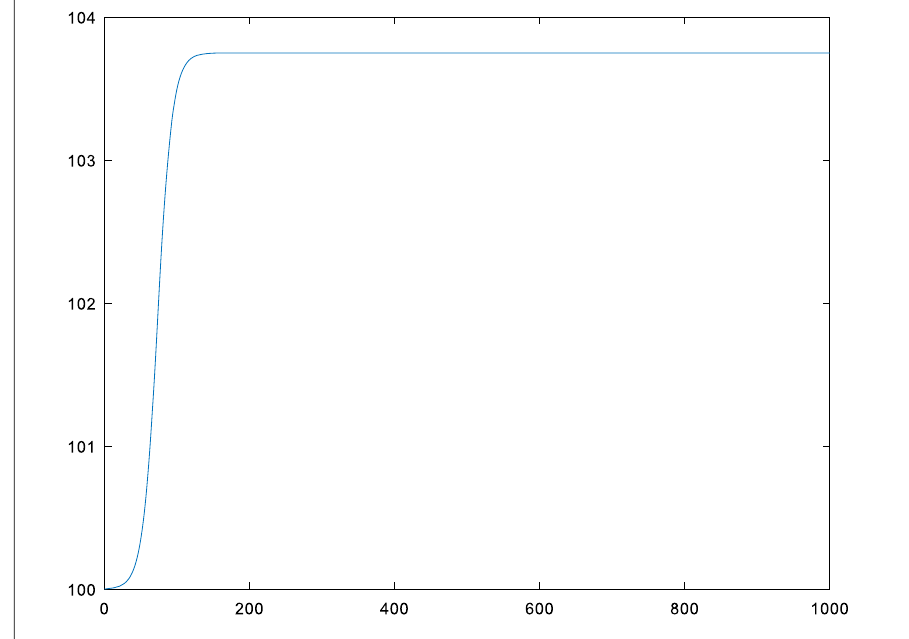
Figure 2 Results of our second example from Sect. 4.2